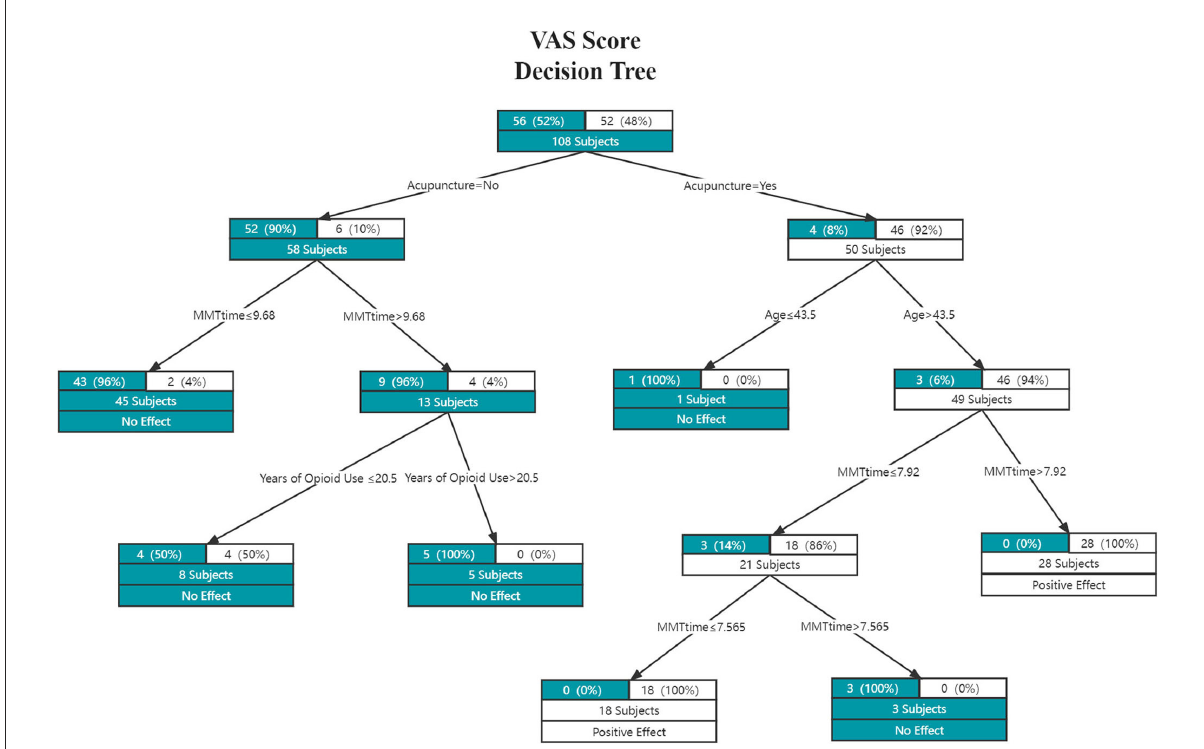
FIGURE3 The VAS score efficacy decision tree. Each edge represents a classification attribute, and each node contains the number of samples from the previous node up to that point, and their distribution among the two classes. Each leaf node is also labeled with the classification choice (White = positive effect; Gree n = no